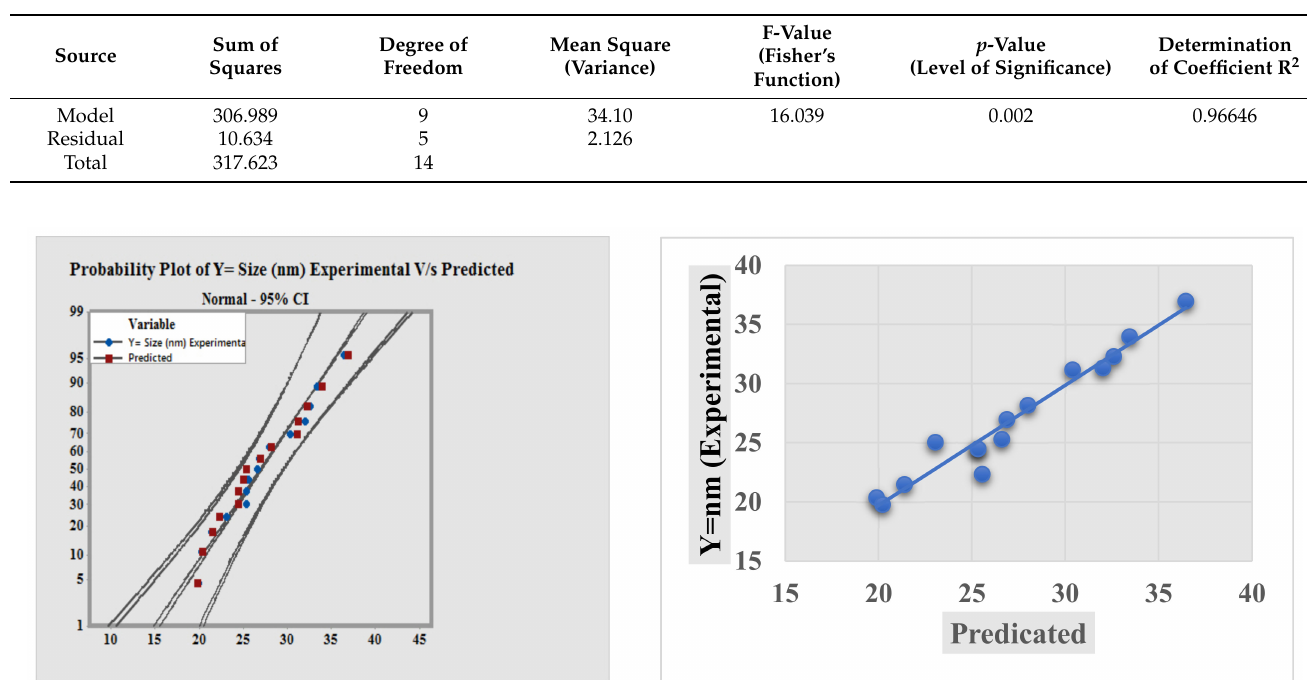
Figure 2. Main effects plot graph for the size of AgNPs. Table 2. Analysis of variance of quadratic model for AgNP synthesis.